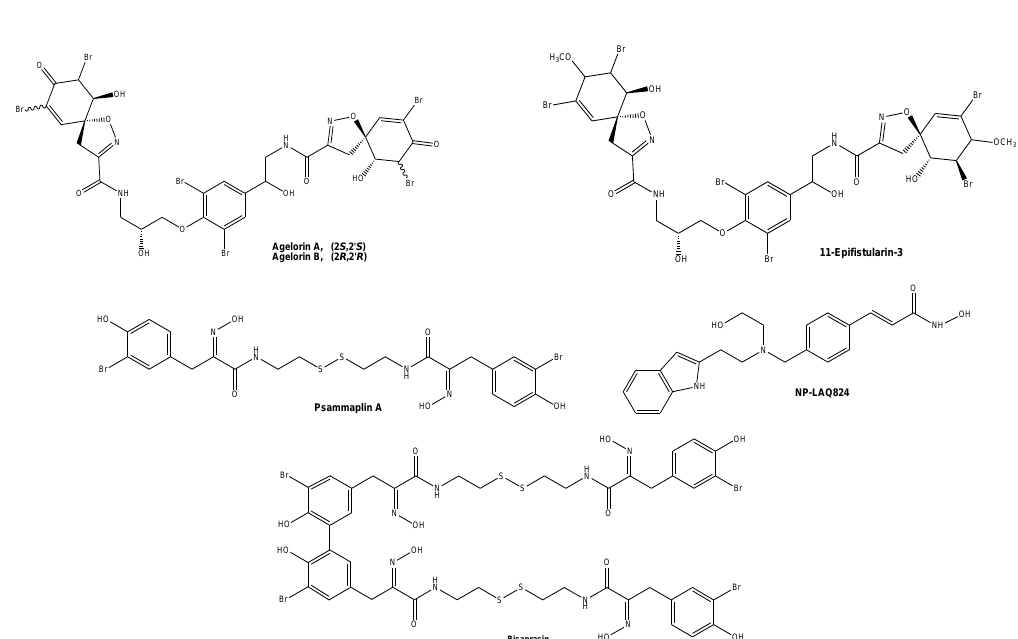
Figure 11. Some bioactive bromotyrosine-derived metabolites found in